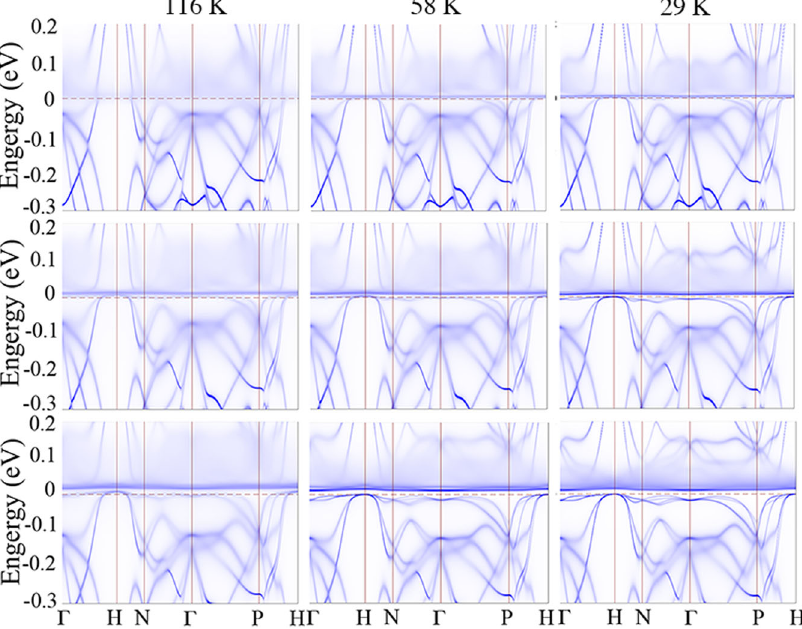
Fig. 1 Momentum-resolved spectral function of Ce 3 Pd 3 Bi 4 from DFT + DMFT at 29, 58, and 116 K for various cell volumes respectively. The panels from top to bottom are 98%, 94%, and 90% compressed V 0 , respectively. From the top-left panel to the right-bottom panel, an energy gap around the Fermi level gradually opens under the lattice shrinking and upon